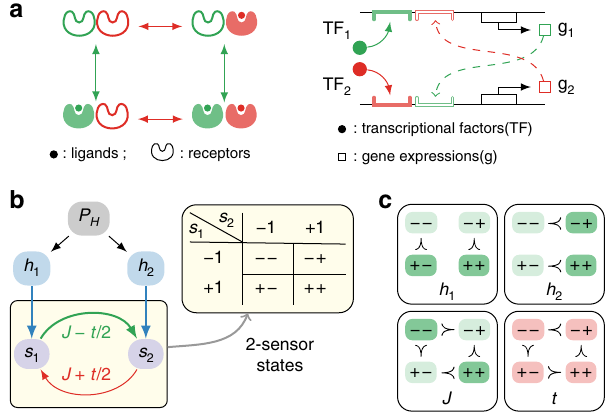
Fig. 1 Model overview. We consider a minimal model of a sensory complex, which includes both external signals and interactions between the sensors. a Physical examples of a sensor system with two interacting sensors: a pair of chemoreceptors with receptor coupling (left) and a pair of transcriptional regulations of gene expressions with cross-feedback (right). b Model schematic. Each sensor is endowed with binary states s 1 = ±1 and s = ±1, so that the sensor complex admits four states: − , − + , + − and 2 ++ . A signal H is drawn from the prior distribution P H and couples to each sensor via the local fi elds h 1 and h 2 . The coupling between the sensors is described by J 12 = J + t ∕ 2 and J 21 = J − t ∕ 2, and can be asymmetric so in general J 12 ≠ J 21 . c The fi eld h i favours the states with s i = + 1 (top row); the coupling J favours the correlated states −− and ++ (bottom left); and the nonequilibrium drive t generates a cyclic bias (bottom